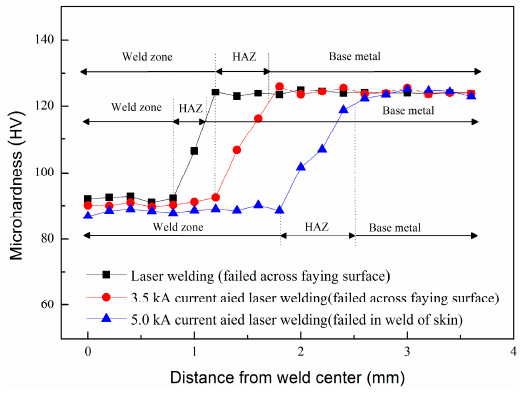
Figure 13. Schematic illustration of the microhardness measurement location and direction.